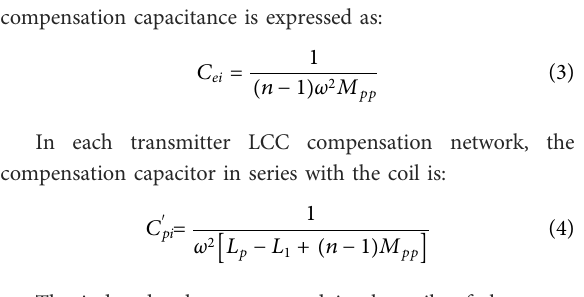
Figure 2. U i is the source of each inverter. L i1 , L i2 , C i1 , C i2 , C pi, and C si are the compensation inductance and capacitance of each LCC compensation network. L pi and L si are inductance of the